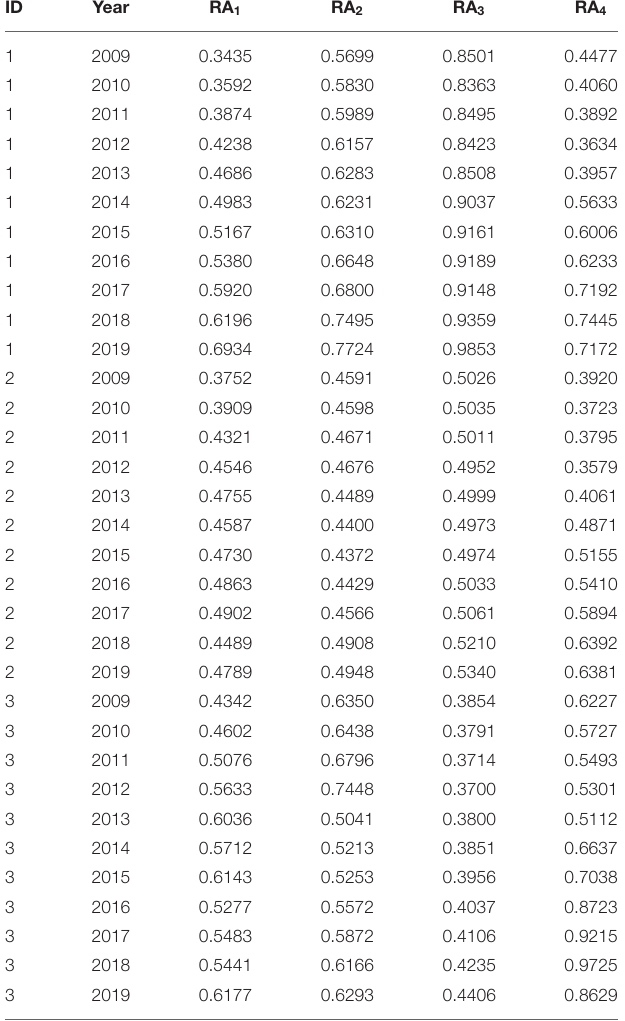
TABLE 4 | Correlation degree of A-level indicators. TABLE 5 | Comprehensive correlation degree of agricultural green development level in the three northeastern